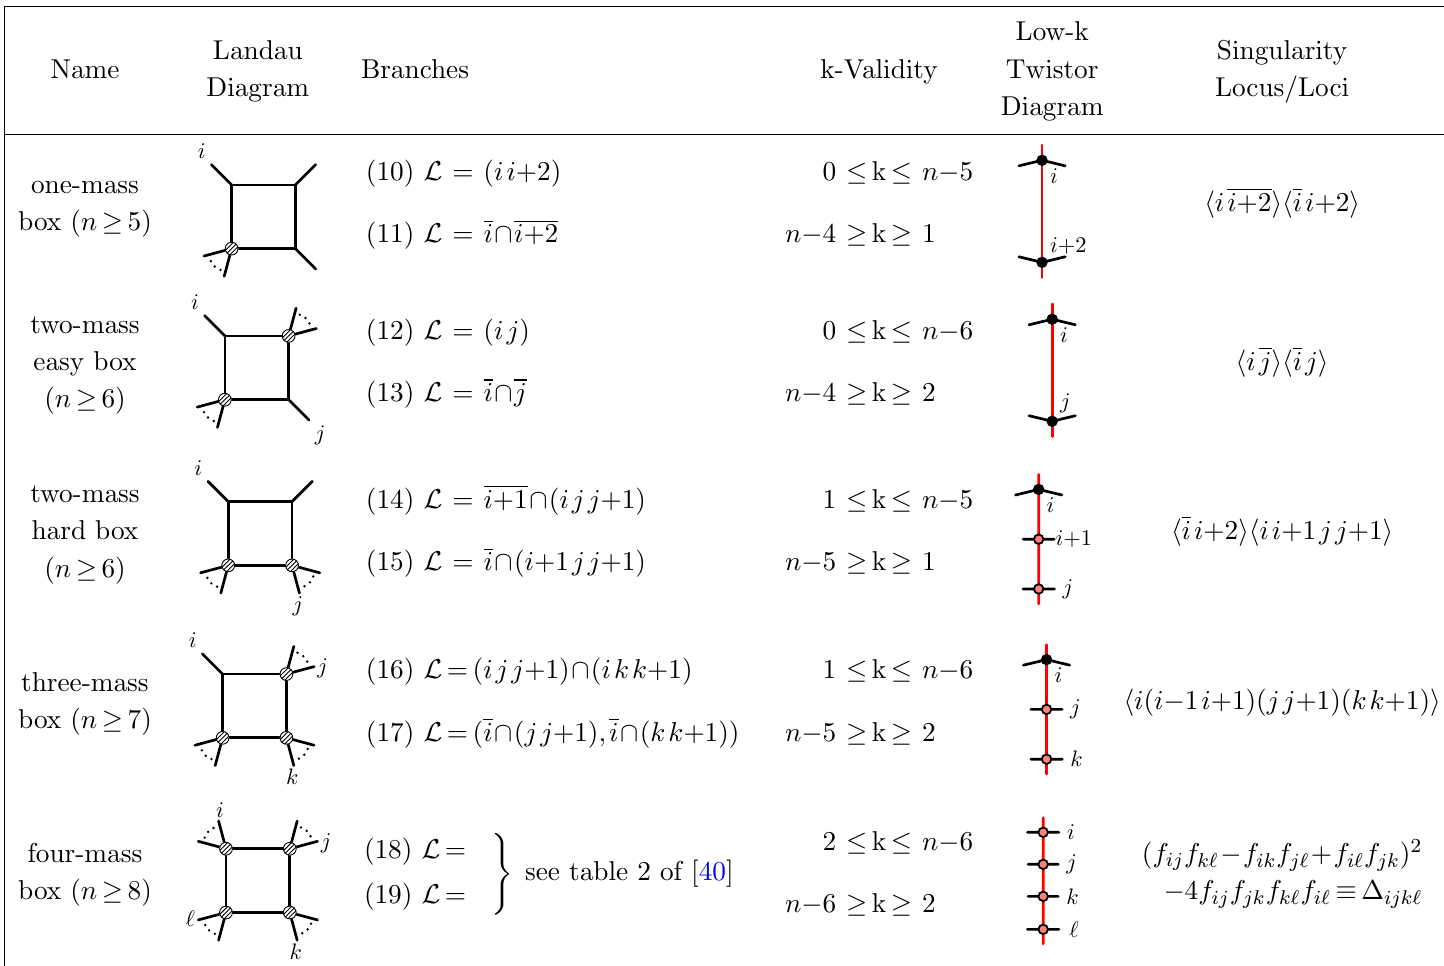
Table 1. This table shows: the eleven Landau diagrams corresponding to sets of one-loop on-shell conditions that can be satis(cid:12)ed for generic projected external data; the nineteen branches of solutions to these on-shell conditions; the range of k for which N k MHV amplituhedra have boundaries of each type; the twistor diagram depicting the low-k solution (or one low-k solution for the one-mass triangle and two-mass hard box); the loci in Conf n ( P 3 ) where the Landau equations for each branch admit nontrivial solutions (where the quantity in the last column vanishes). At one loop it happens that the loci are the same for each branch of solutions to a given set of on-shell conditions. Here (cid:11);(cid:12) are arbitrary numbers, A is an arbitrary point in P 3 , P is an arbitrary plane in P 3 , (cid:26) ( (cid:11) ) ;(cid:27) ( (cid:11) ) are de(cid:12)ned in eq. (3.1), f ab (cid:17) h aa +1 bb +1 i , and h i ( i (cid:0) 1 i +1)( j j +1)( kk +1) i (cid:17) h i (cid:0) 1 ij j +1 ih ii +1 kk +1 i(cid:0) ( j $ k